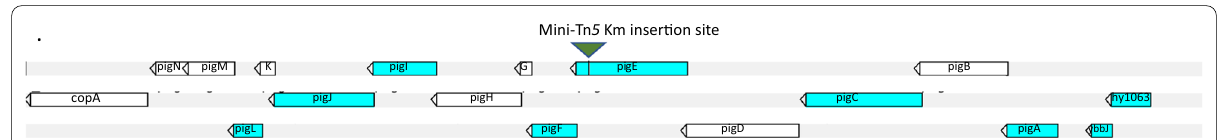
Fig. 3 Transposon insertion site within pig cluster of Serratia marcescens strain Tn246. The pig genes are responsible for biosynthesis of prodigiosin. Mini-Tn 5 km, transposon mini-Tn 5